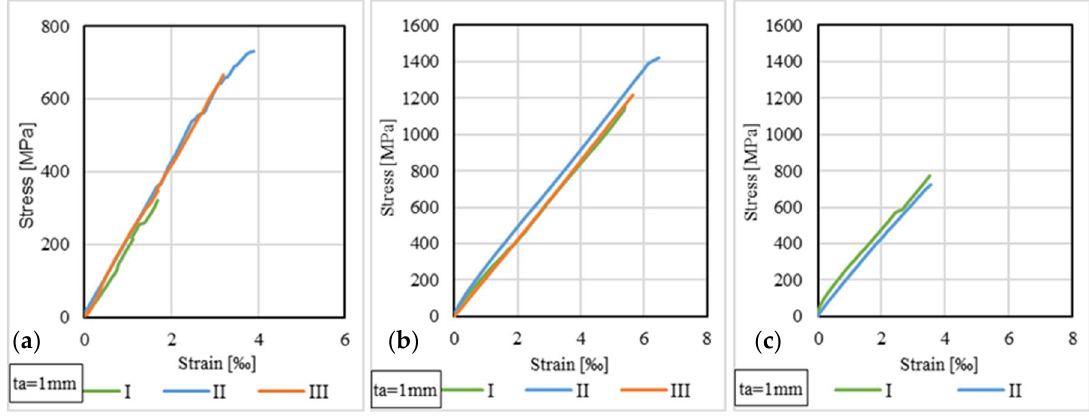
Figure 17. Stress–strain curves for M514 strip: ( a ) S-M514-30-1-I, II, III; ( b ) S-M514-330-1-I, II, III; ( c ) NS-M514-30-1-I, II.